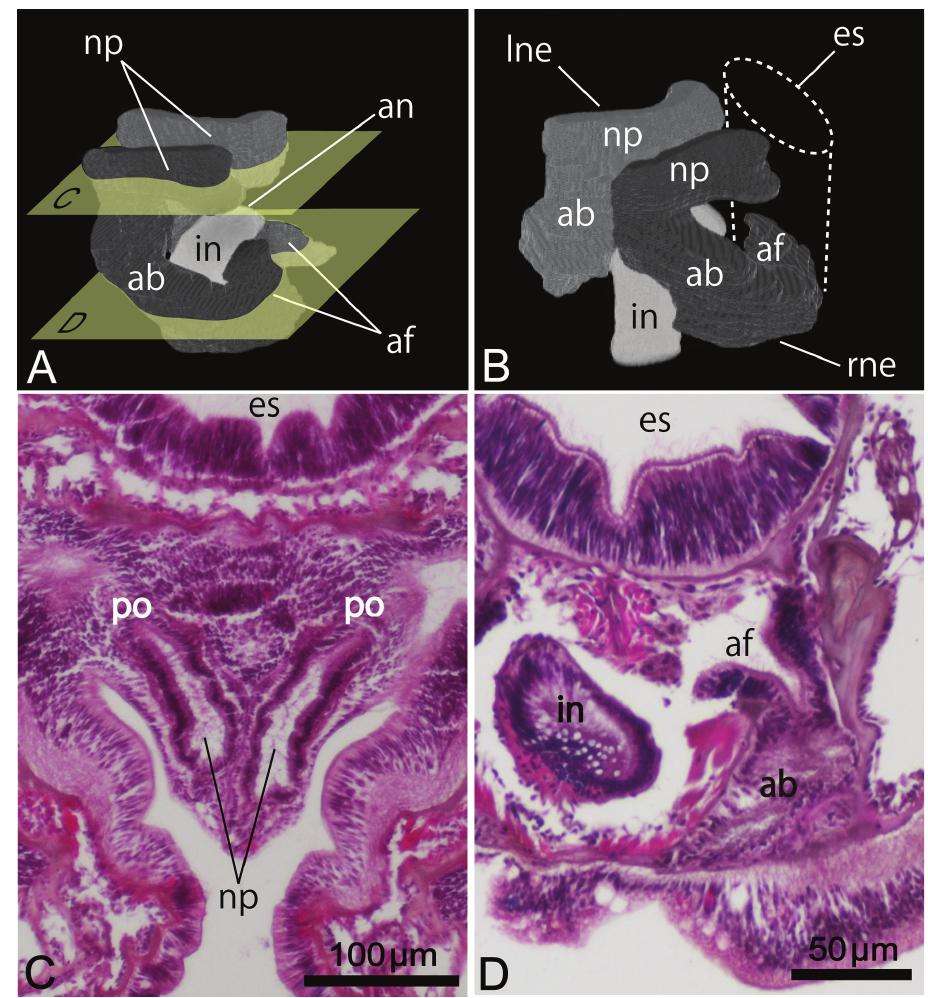
Figure 5. Reconstructed three-dimensional images and transverse sections of the nephridium of Phoronis ijimai Oka, 1897, from NSMT-Te 886 ( A, B, D ) and NSMT-Te 884 ( C ). A Lateral view, showing the long nephridial papillae above the anus B dorsolateral view, showing the offset arrangement of the nephridia, with the curved ascending branch and large anal funnel extending toward the esophagus C transverse section through the nephridial papilla, showing the nephridiopore D transverse section through the ascending branch, showing the large anal funnel opening toward the esophagus, Abbreviations: ab ascending branch; af anal funnel; an anus; es esophagus; in intestine; lne left nephridium; np nephridial papilla; p nephridiopore; rne right nephridium. Planes C and D in panel A indicate the positions of the transverse sections in C and D